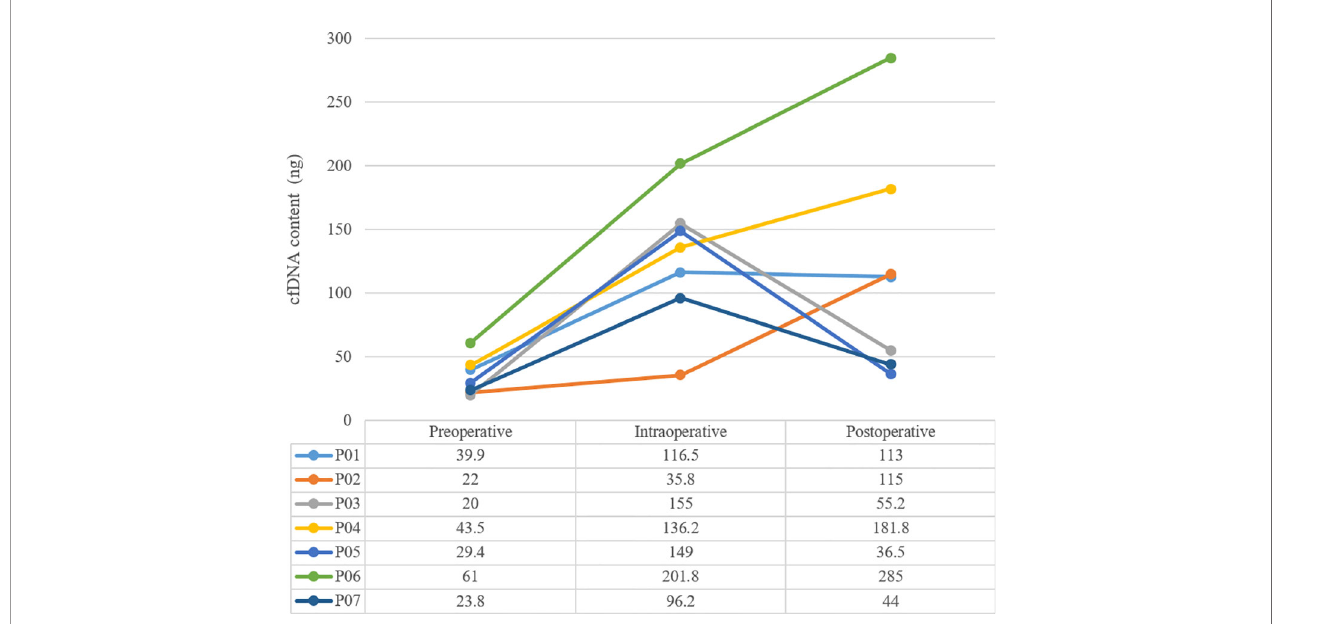
FIGURE 1 | Perioperative dynamic monitoring of cfDNA